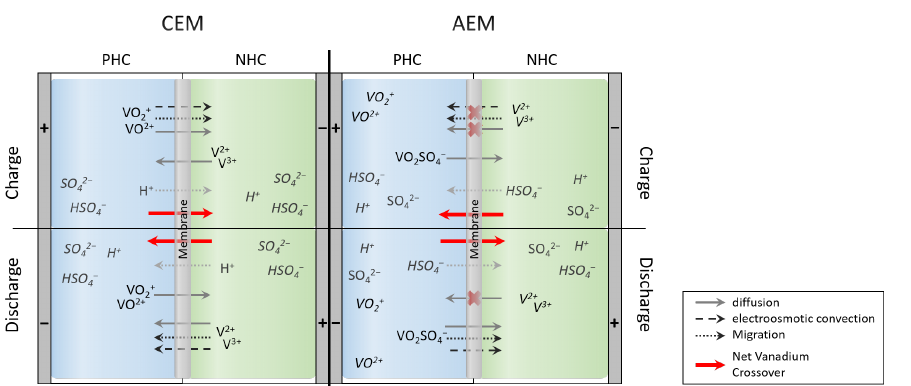
Figure 1. Simplified scheme for vanadium crossover processes in dependence on membrane type (cation and anion exchange membrane) and state of operation (charge and discharge). Transfer of ions for charge balance is included, transfer of water is not